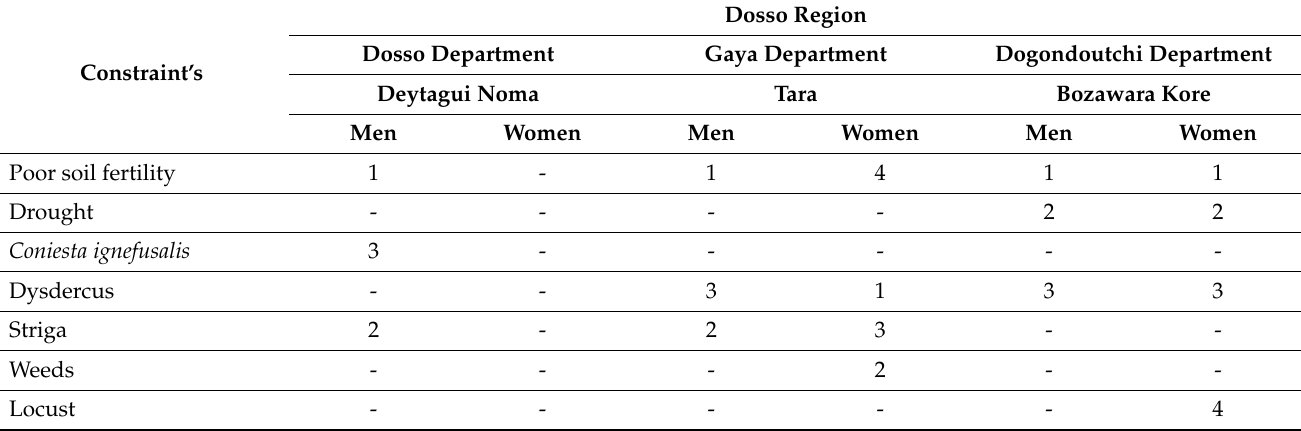
Table 5. Farmers’ pearl millet production constraints ranked according to importance in three departments (Dogondoutchi, Dosso, and Gaya) of the Dosso region in Niger.